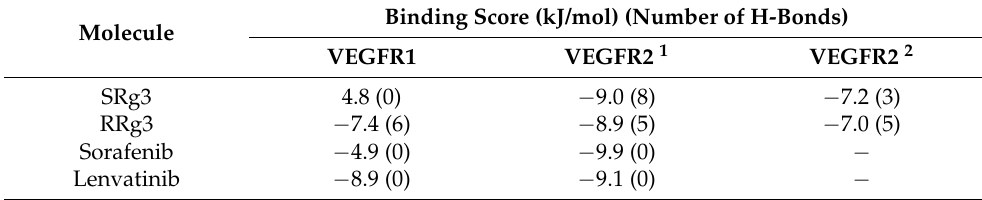
Table 2. Binding score (kJ/mol) of Rg3 epimers and growth factor receptors and the number of hydrogen binding (H-bond) predicted by Chimera program and Autodock vina